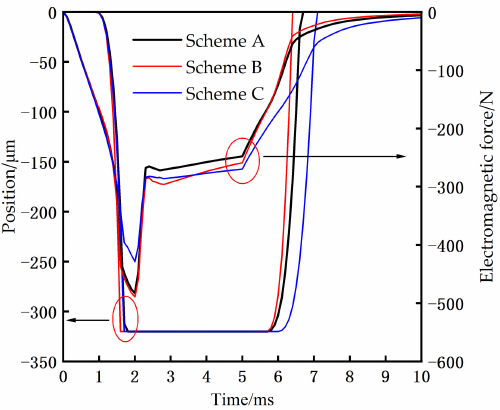
Figure 19. Comparison of electromagnetic force and armature displacement before and after